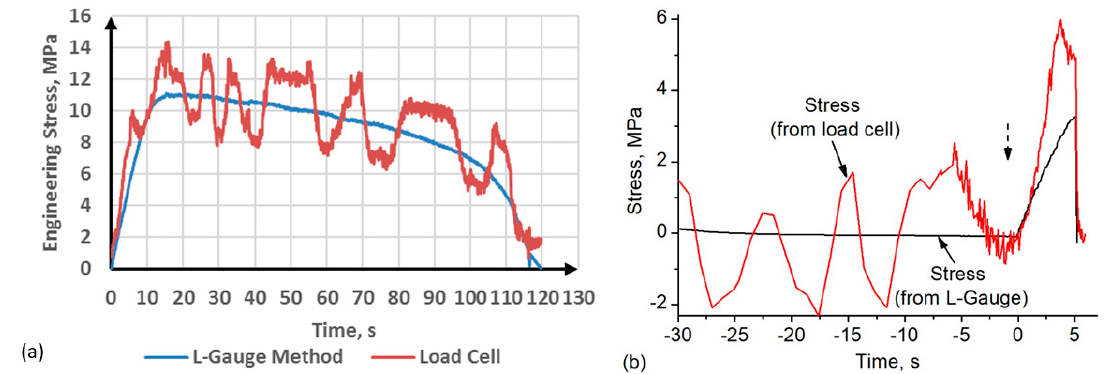
Figure 8. Comparison of stress evolution curves determined using the built-in load cell and new L-gauge method, as a function of time in AA611 alloy at ( a ) 535 °C (2.8% f L ) and ( b ) 571 °C (5.8% f L ). The beginning of tensile loading was set at 0 for the sake of simplicity (see the dotted arrow).